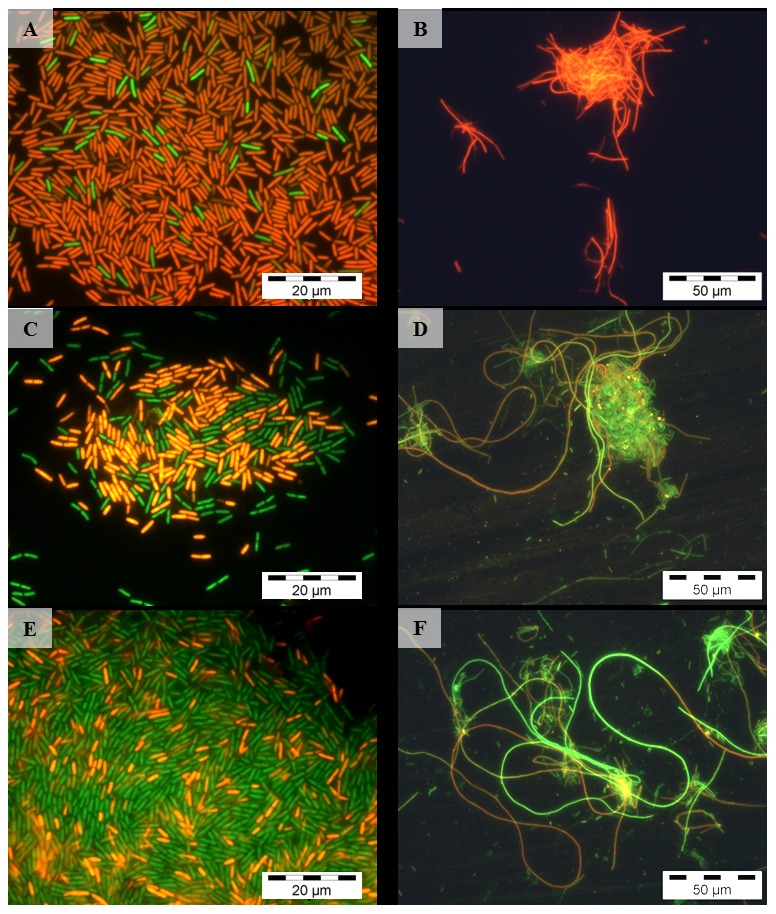
Representative microscopic pictures of Paenibacillus sp. JG-TB8, stained with the Live/Dead Kit after the treatment with uranium under aerobic (left) and anaerobic (right) conditions at pH 3 (A, B), pH 4.5 (C, D), and pH 6 (E, F) for 48 hours.Pictures were taken in fluorescence mode using a fluorescence mirror unit (U-MSWB; Olympus Europa Holding GmbH, Hamburg, Germany) with excitation wavelengths between 420 and 460 nm.